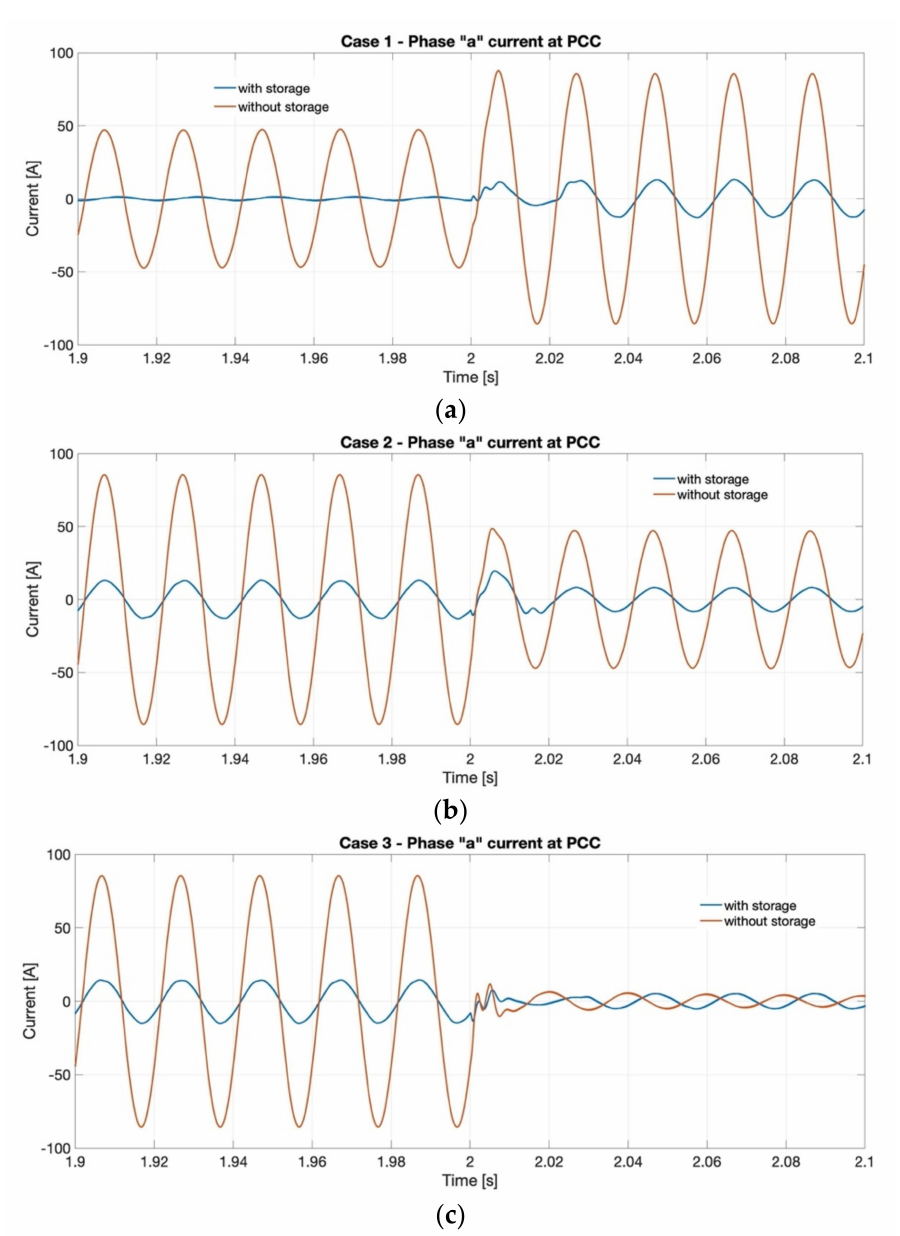
Figure 9. Current behavior at PCC: ( a ) Case 1, ( b ) Case 2 and ( c ) Case 3. For what concerns the voltage frequency, as pictured in Figure 10, a significantly lower peak during the transient is remarked when the HESS is coupled. Specifically, the peak value is reduced by 77% in Case 1, by 64% in Case 2 and by 80% in Case 3 when the largest wave power variation is imposed. It is remarked that, as stated before for the power smoothing performance, the benefits of coupling the HESS to the highly oscillating wave power plant increase with the power ramp at the wave energy converter. Although for the considered system the peak value is under 0.5% in all the investigated scenarios, such impact is very important under the RES increasing integration perspective, particularly highly variable RES such as wave generation. Moreover, the frequency stabilizes faster when the HESS is coupled to the wave power plant, reaching the set value (50 Hz) in a time shorter by 10% in the first scenario, 28% in the second and 42% in the third one. Also in this case the beneficial effect of the HESS integration increases with the solicitation caused by the